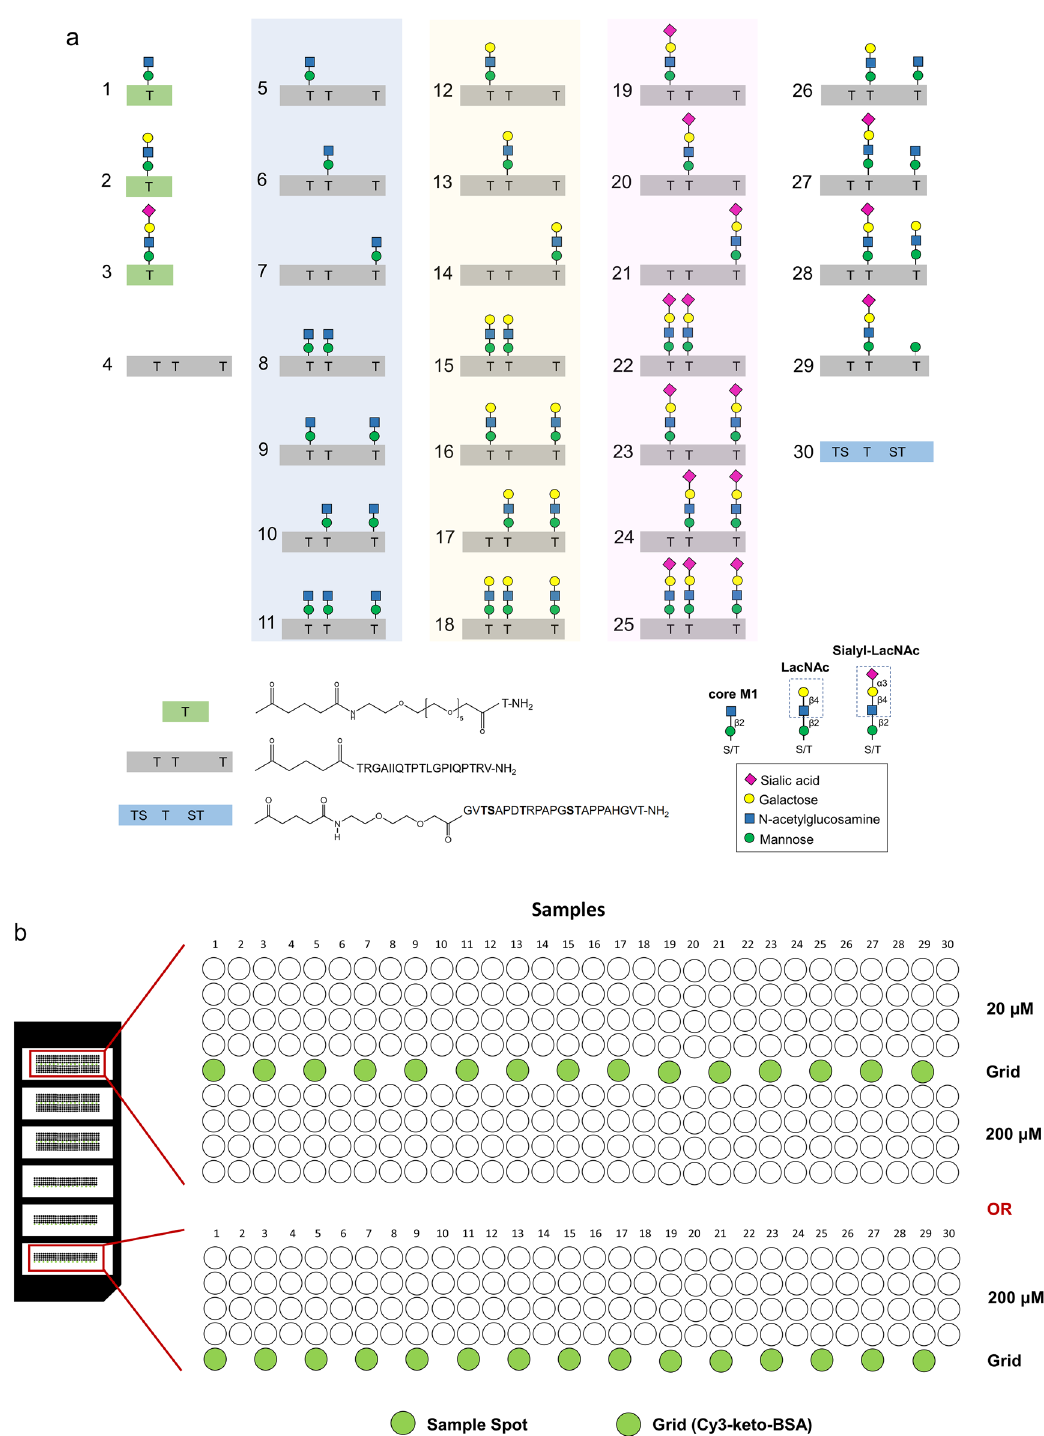
Figure 2. Glycoblotting-based microarray for galectin interaction profiling with core M1 modification. Synthetic α-DG core M1 glycoconjugates used for microarray experiment ( a ). Compounds were robotically printed in quadruplets at 20 and/or 200 μM on an aminooxy- coated plastic slide. Subsequently, a six-chamber rubber silicon sheet was attached. Green spots correspond to cyanine 3-keto-BSA (Cy3-keto-BSA) as grid ( b